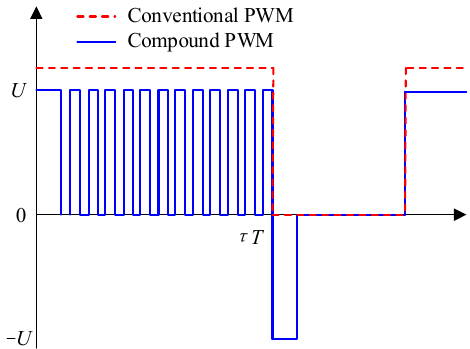
Figure 4. Schematic of two PWM control signals.